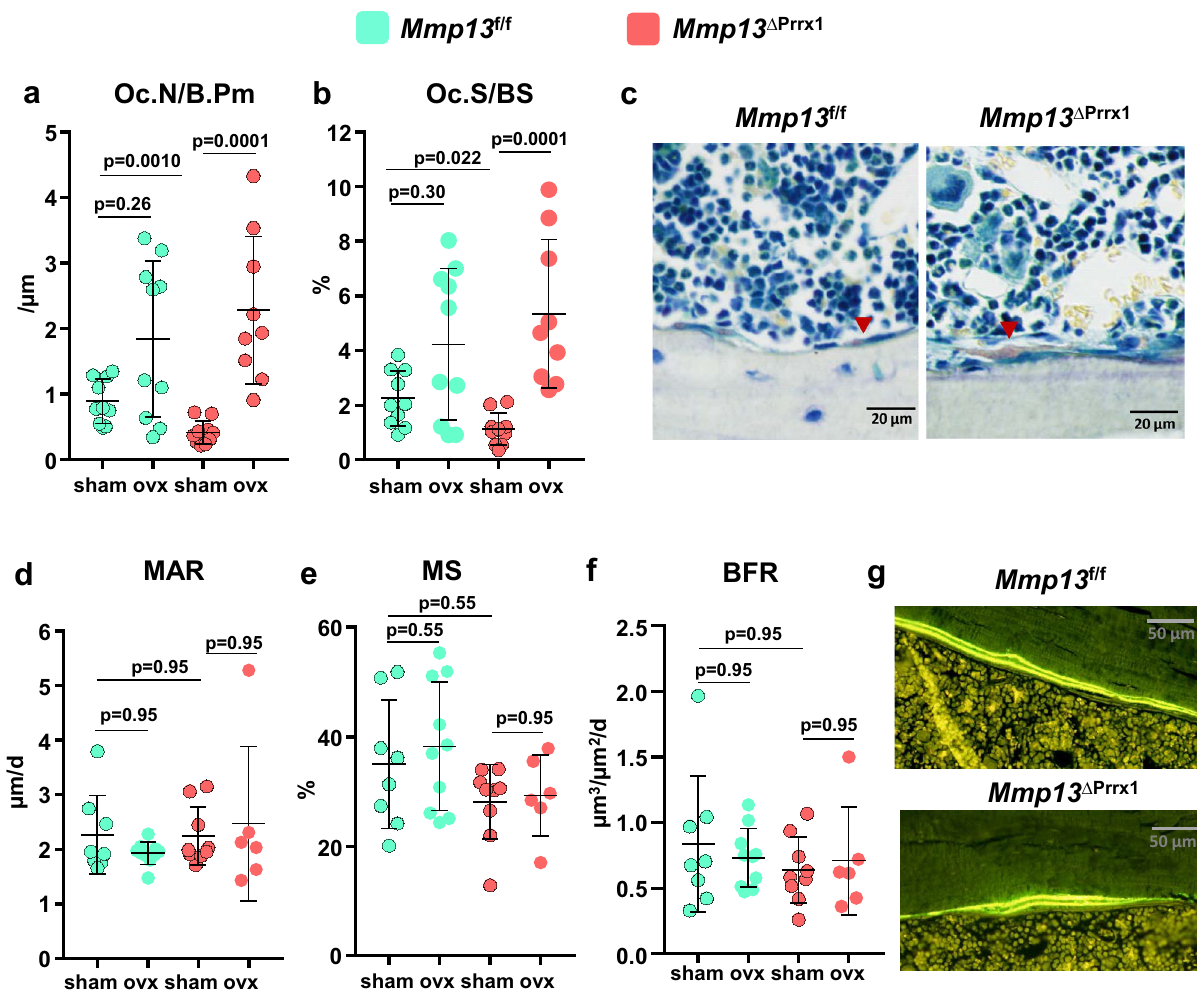
Figure 5. Mmp13 deletion decreases osteoclast number at the endocortical surface of the femur. Histology and dynamic histomorphometry were evaluated at the endocortical bone surface in longitudinal undecalcified femur sections from 6-month-old female mice sham or OVX operated. ( a ) Osteoclast number per bone perimeter, ( b ) osteoclast surface per bone surface, and ( c ) representative microphotographs of osteoclasts in sections from sham animals stained with tartrate-resistant acid phosphate ( Acp5 ). ( d ) Mineral apposition rate, ( e ) mineralizing surface and ( f ) bone formation rate, and ( g ) representative photomicrographs of cortical bone labeled with calcein in sections from sham animals. Data represent mean ± S.D. (n = 6–10 mice/group); P values by Kruskal– Wallis